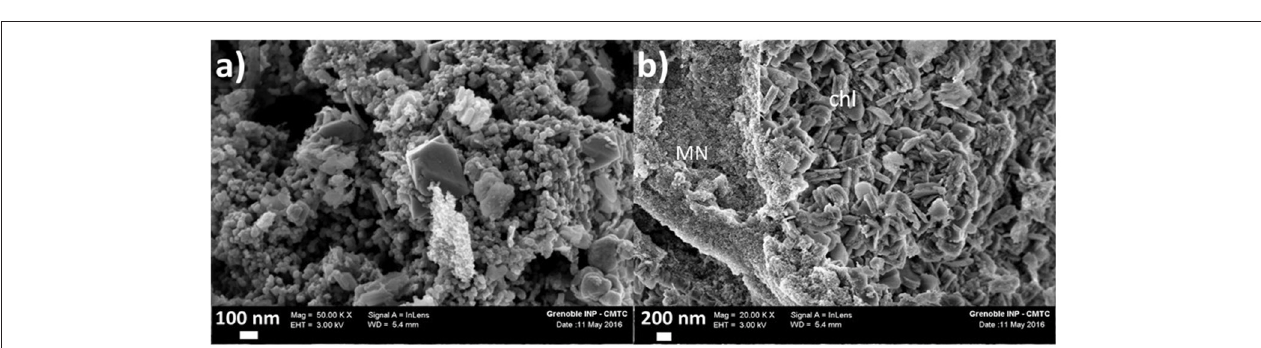
FIGURE 8 | XPRD pattern of decalcified steel slag after hydrothermal oxidation at 250 ◦ C in 1M acetic acid solution: magnetite (M), chlorite (C), and hematite (H).